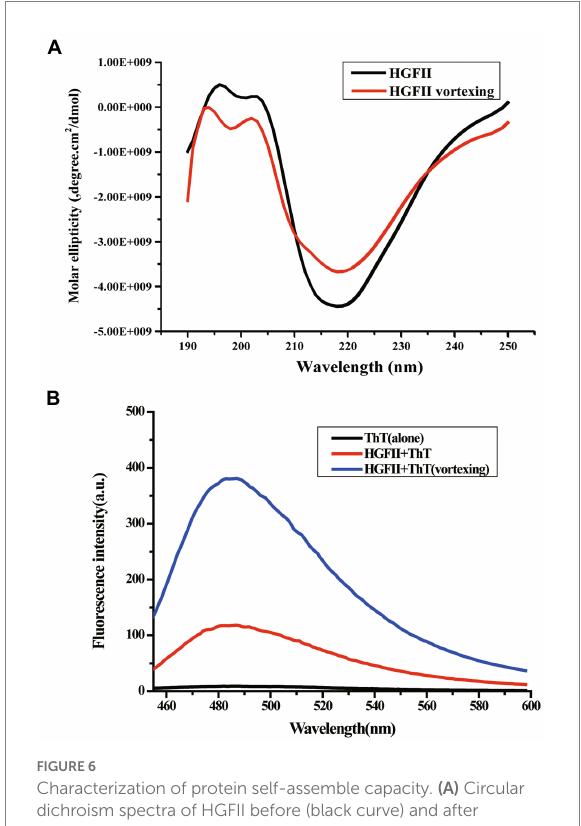
FIGURE 6 Characterization of protein self-assemble capacity. (A) Circular dichroism spectra of HGFII before (black curve) and after vortexing (red curve). (B) ThT fluorescence intensity assay of HGFII.